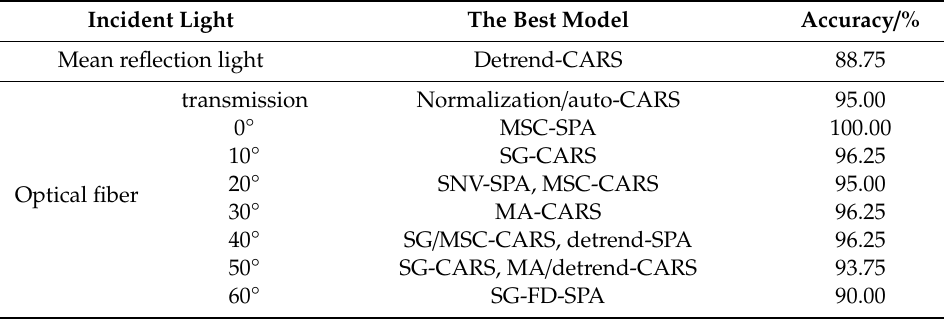
Table 10. The highest accuracy of the best model under different incident modes.